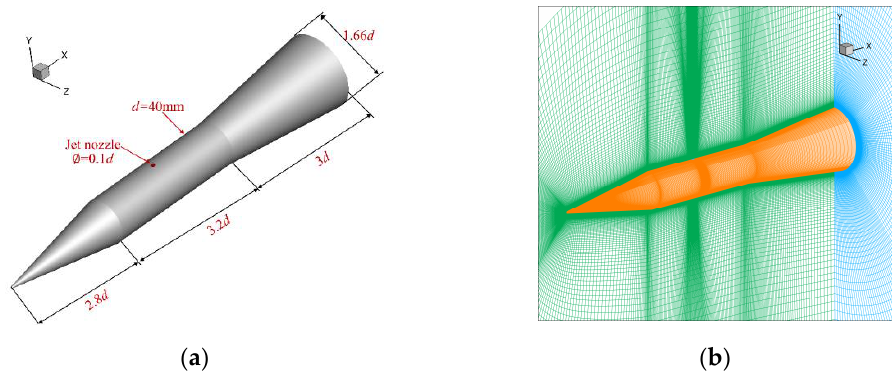
Figure 4. Geometric parameters and grids of the CCF shape: ( a ) Geometric parameters and 3D model; ( b )grids for computational. ( b ) grids for